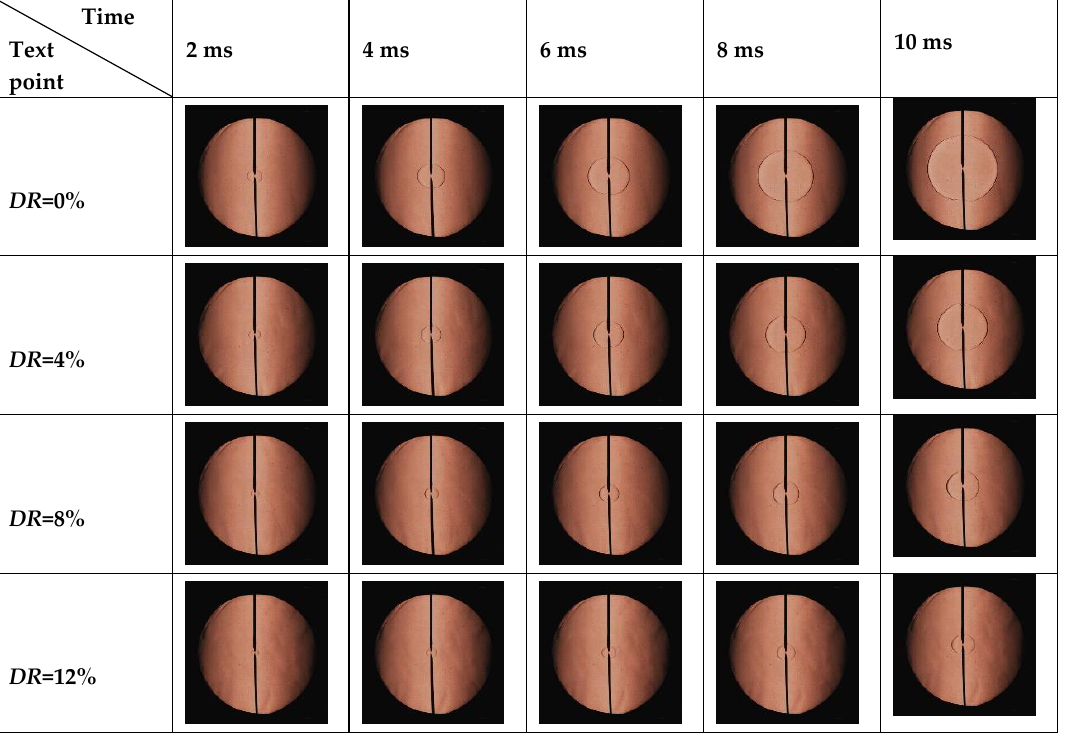
Figure A3. Schlieren photographs for flame propagation process under di ff erent dilution rates ( T u = 423 K, p u = 0.1 MPa, Φ =